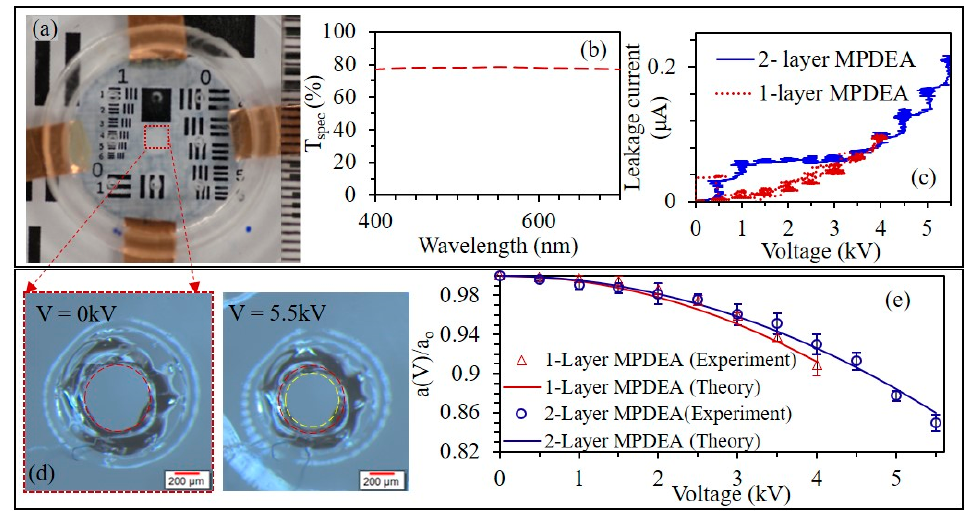
Figure 7. ( a ) A prototype of the two-layered transparent MPDEA device with inkjet-printed PE- DOT:PSS thin film electrode; ( b ) inline transmittance of the same device for the visible spectrum. When it is electrically activated, the active area expands, and the hole diameter shrinks: ( c ) the applied voltage and the leakage current of the 1 and 2-layer MPDEAs; ( d ) one of the holes at passive (0 kV) and activated state (5.5 kV); ( e ) plot showing a gradual reduction in the hole diameter when the activation voltage is gradually increased (theoretical plots are based on Equation (3)).